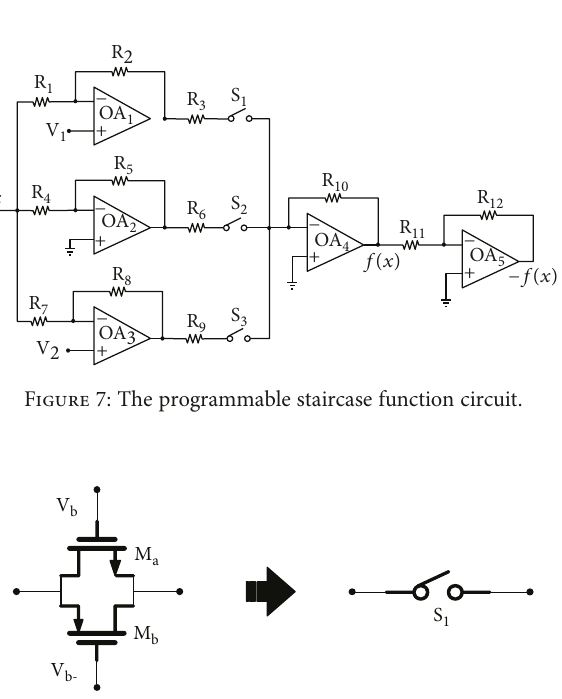
Figure 8: The digitally programmable MOS switch.